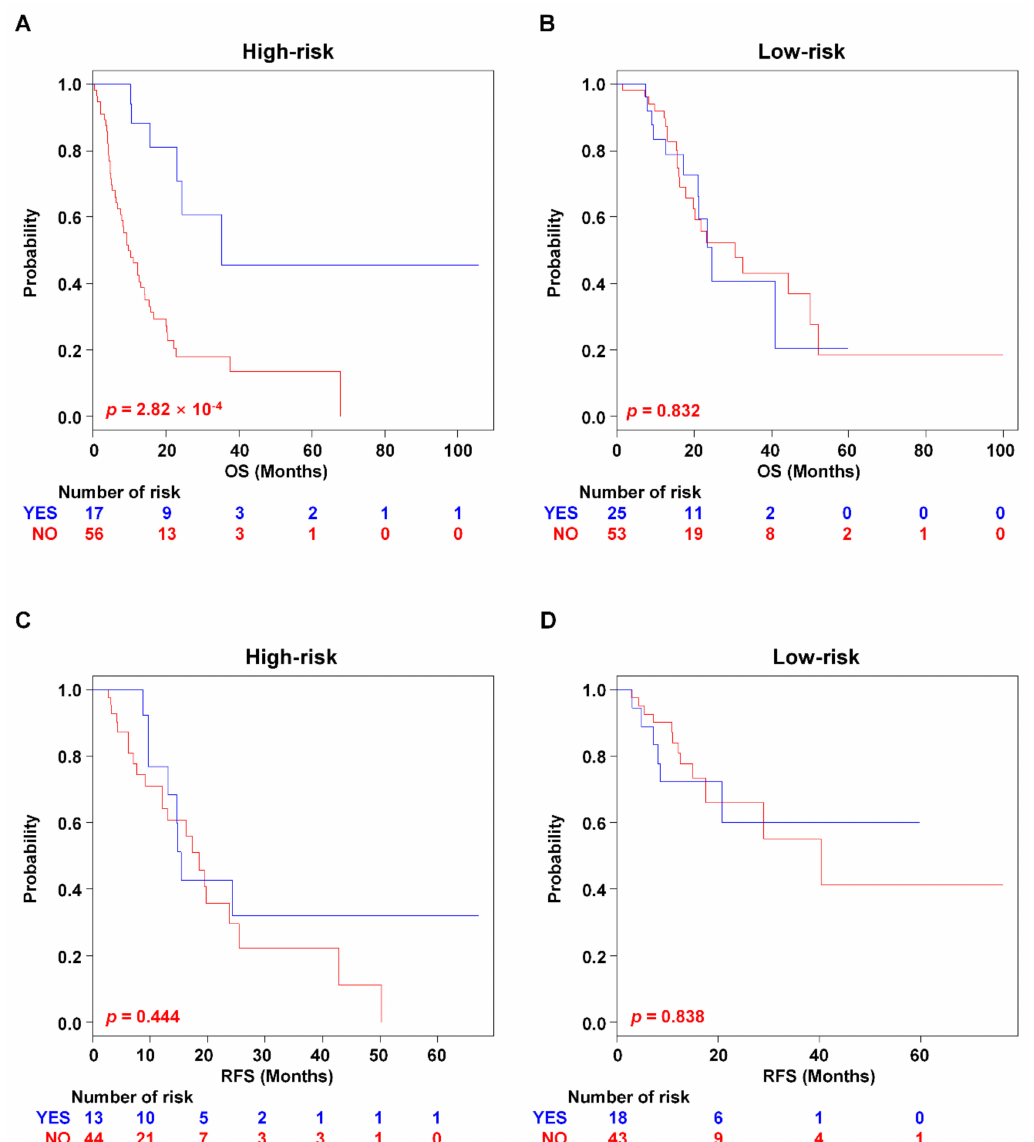
Figure 6. Kaplan–Meier survival analysis of PAC patients with radiation therapy. The patients were separated into risk-subgroups according to radiotherapy. Kaplan–Meir analyses were used to evaluate the therapeutic advantage. ( A , B ) Kaplan–Meier plots for OS of two risk-subgroups. ( C , D ) Kaplan–Meier plots for RFS of two risk-subgroups. p -Values were computed by the log-rank